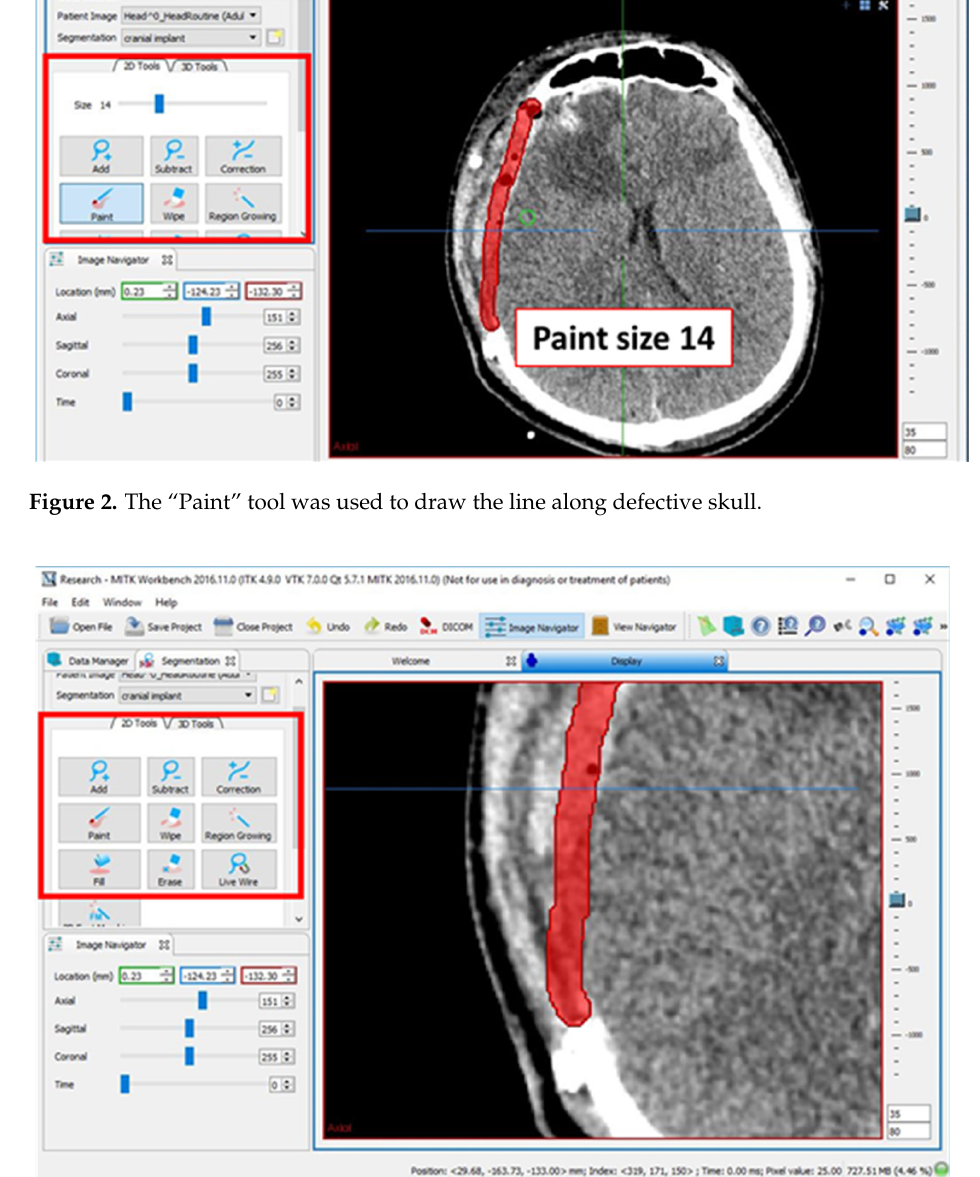
Figure 3. The axial slice of the segmentation was enlarged to view the line drawn and for editing